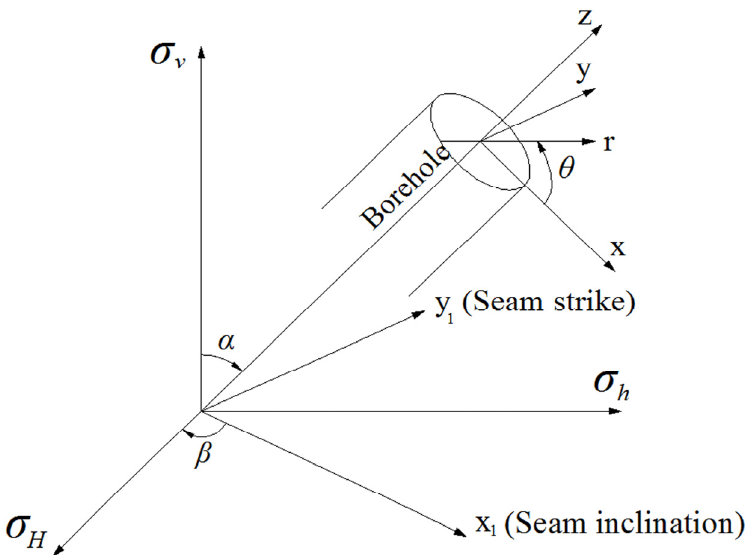
Figure 2. Stress state of the